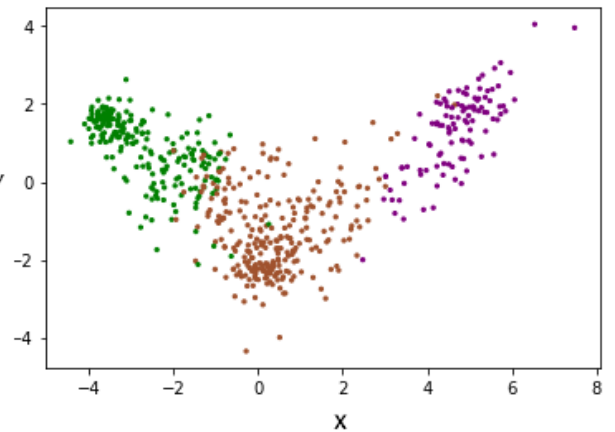
Figure 11. Data redistribution after applying LDA as a supervised dimensionality reduction method. (Green—Mild, Brown—Moderate and Purple—Severe).